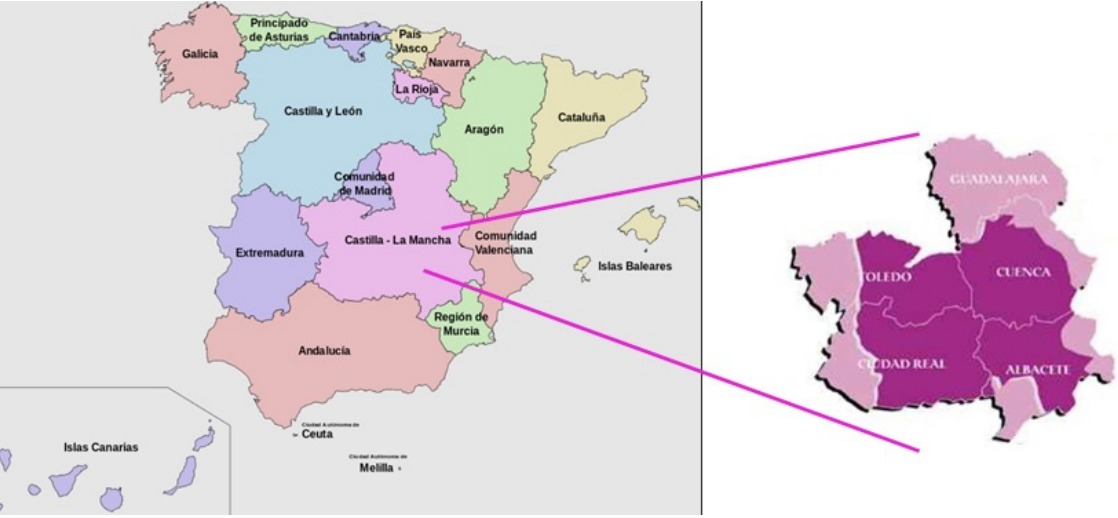
Figure 2. Production area of Protected Designation of Origin (PDO) “Queso Manchego” in the center of Spain.